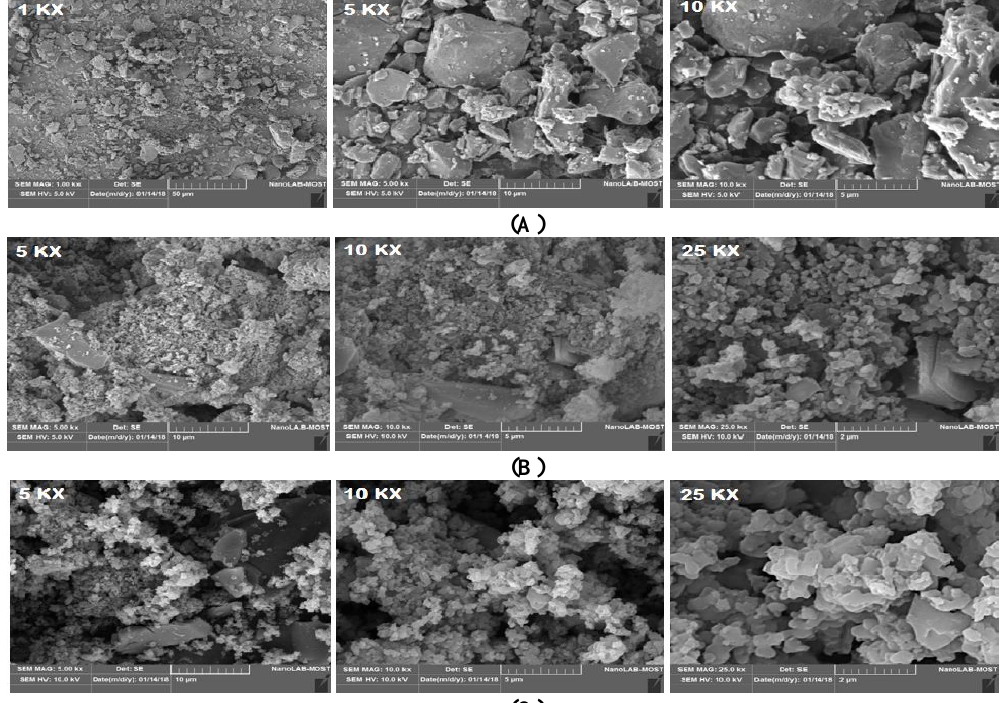
Figure (3) SEM micrographs of untreated SM (A), MC9 (B), and MC9s